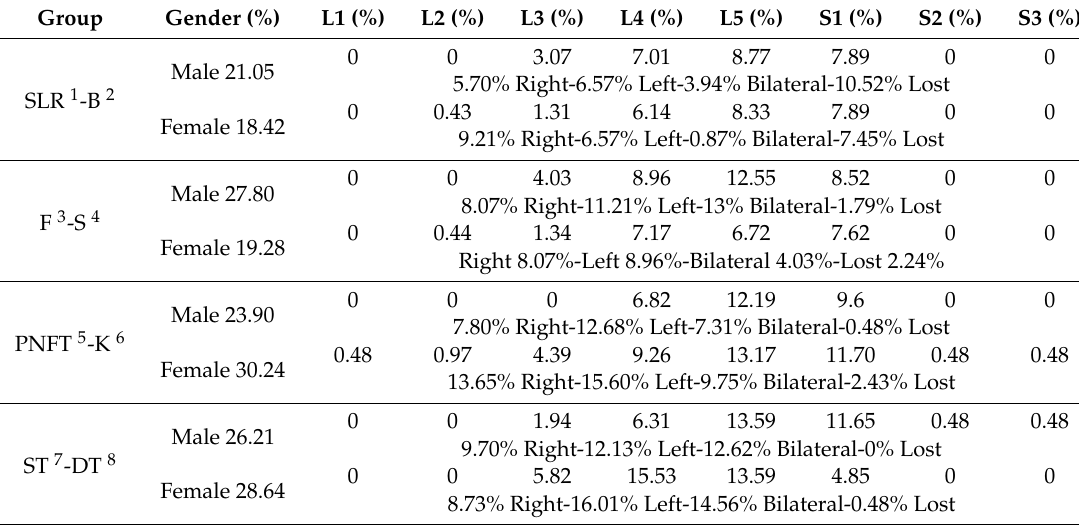
Table 2. Nerve root a ff ected by group and gender.